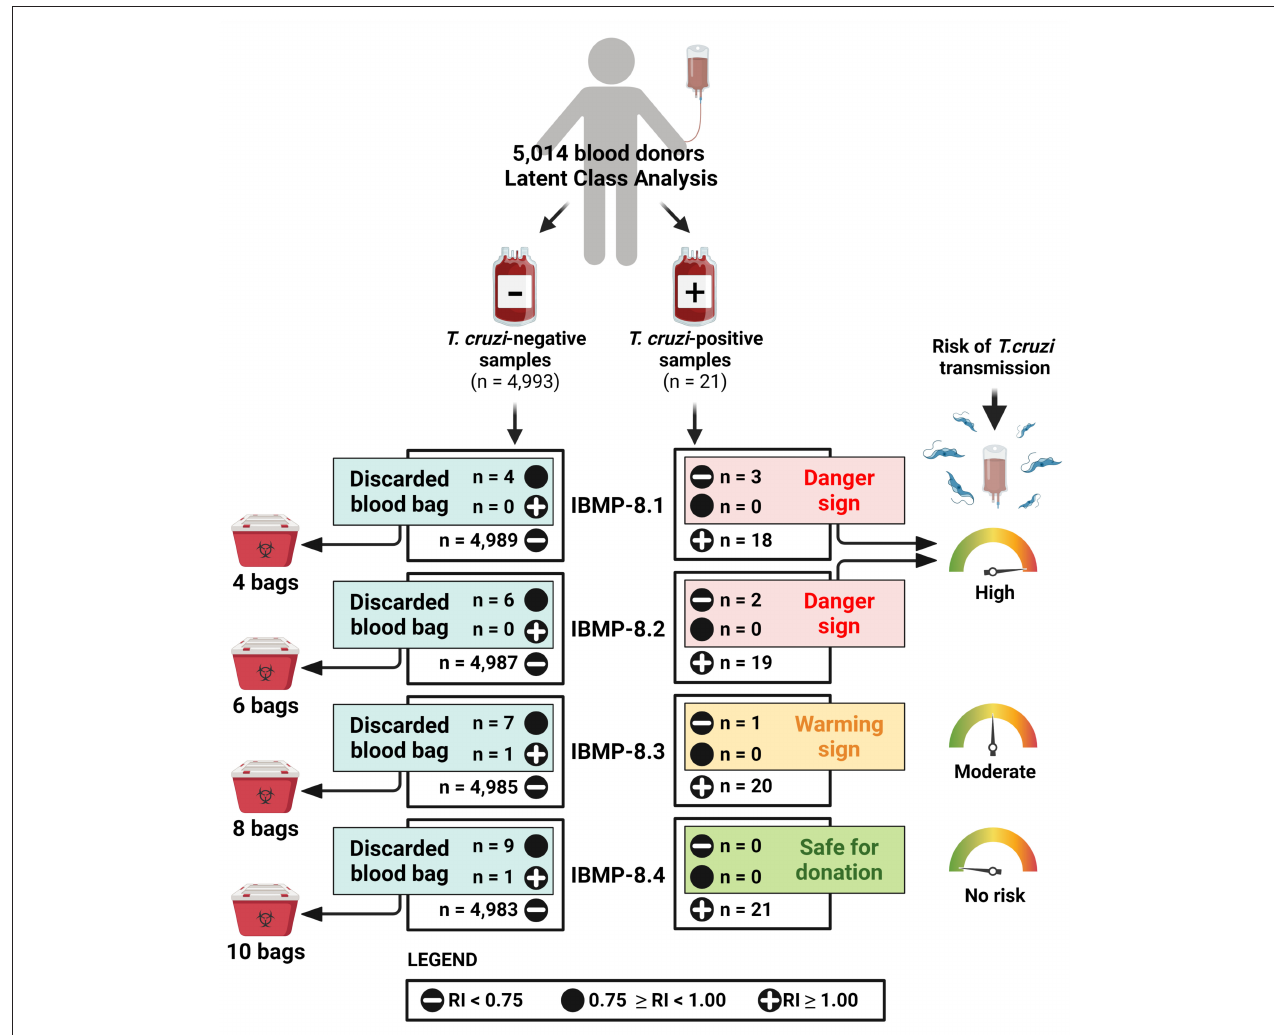
FIGURE 5 | Analysis of individual use of chimeric IBMP proteins for CD serological. RI, reactivity index.